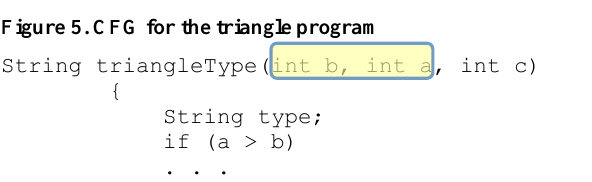
Figure 6. An example of a mutant of the triangle program